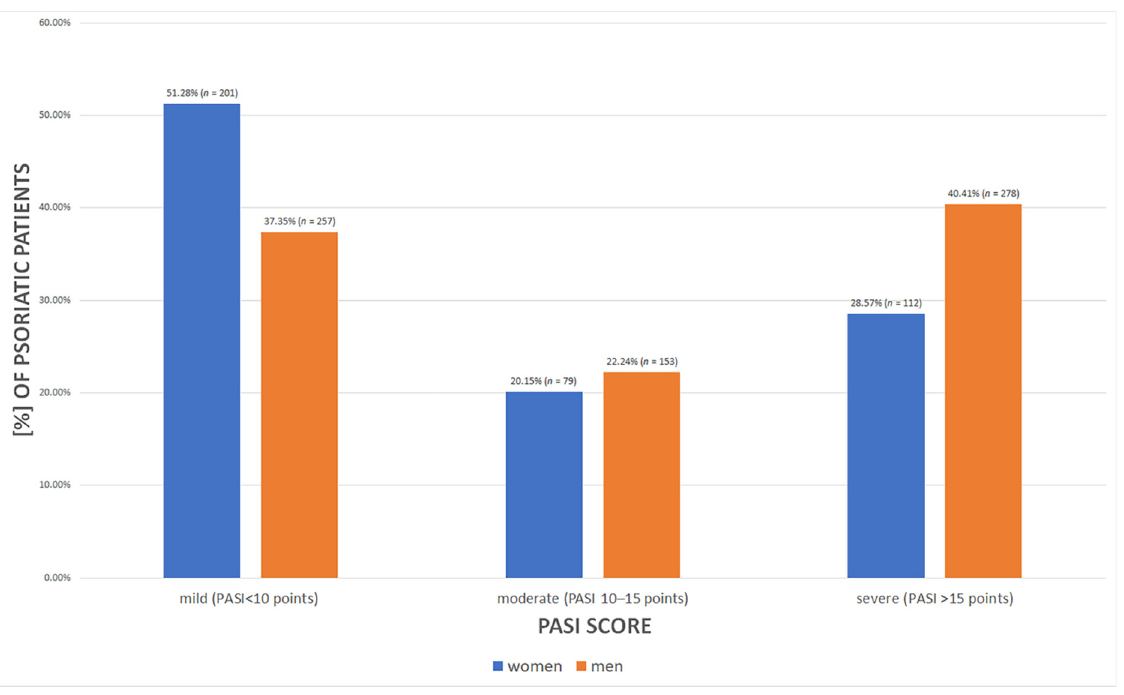
Figure 3. The severity of psoriasis in female and male psoriatic patients defined by PASI score ( p = 0.00002).